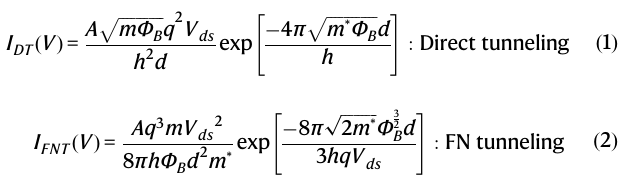
Fig. 3 | Electrical response and device working mechanism of CNT B -M/CNT T vdWI. a Energy band diagrams for the downward polarization (i, ii) and upward polarization(iii,iv)indicatingtheCNT B -M/CNT T memoryoperation. b , c Ln( I(V)/V 2 )